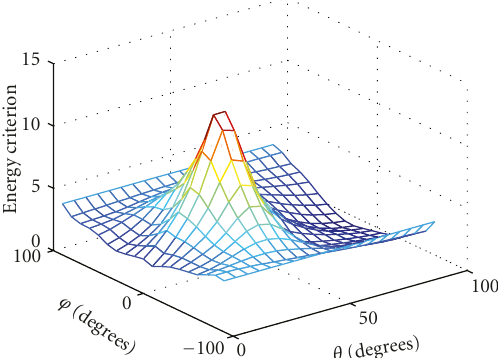
Figure 6: Example of an energy criterion curve as a function of ϕ and θ .